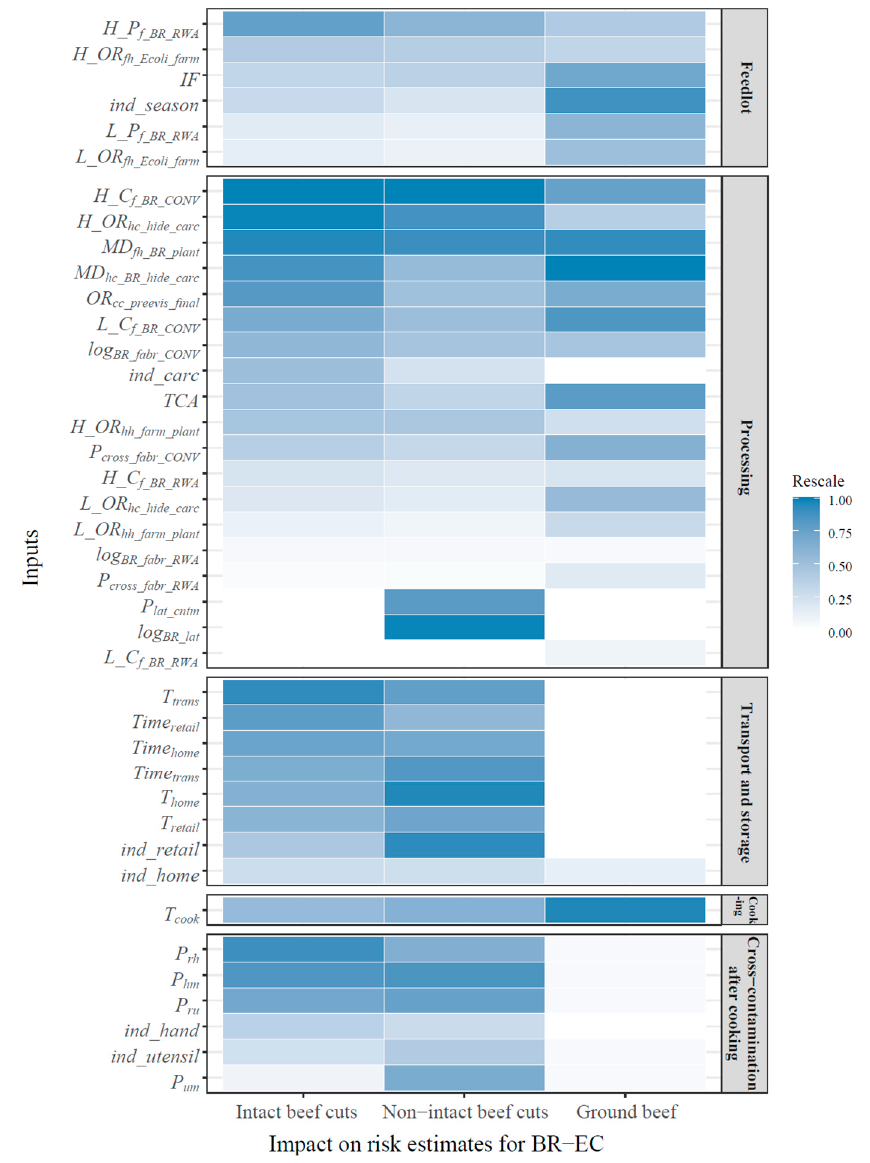
Figure 3. Ranking of the impacts of individual stochastic input variables on the final outputs. The deeper the color, the greater the impact of the input on the output. Refer to Tables S1–S9 for input variable names.